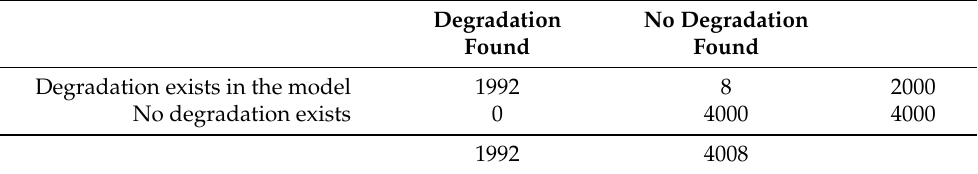
Figure 4. The scheme of the material degradation zone identification procedure. Table 3. CNN accuracy of the identification of the material degradation occurence (for details, see